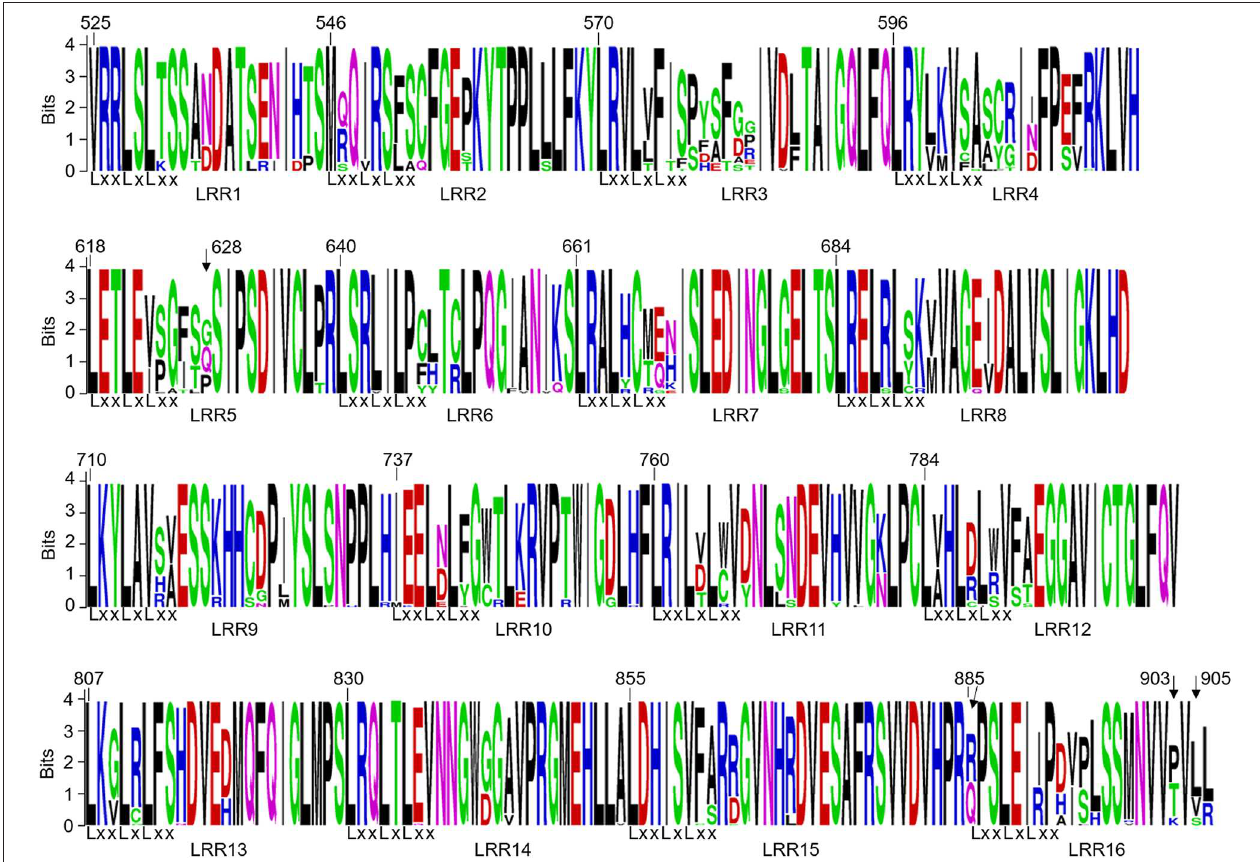
FIGURE 4 | Sequence logos of 16 LRR motifs encoded by Pm21 alleles. In the LxxLxLxx motifs, x represents the predicted solvent-exposed LRR residues, and L represents a leucine or another aliphatic amino acid residue. The sites at positions 628, 885, 903, and 905 pointed by arrows are predicted to be under positive